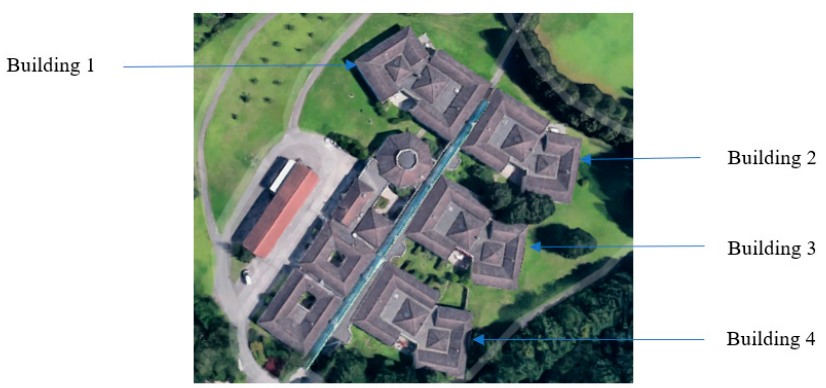
Figure 2. Locations of the survey sites.